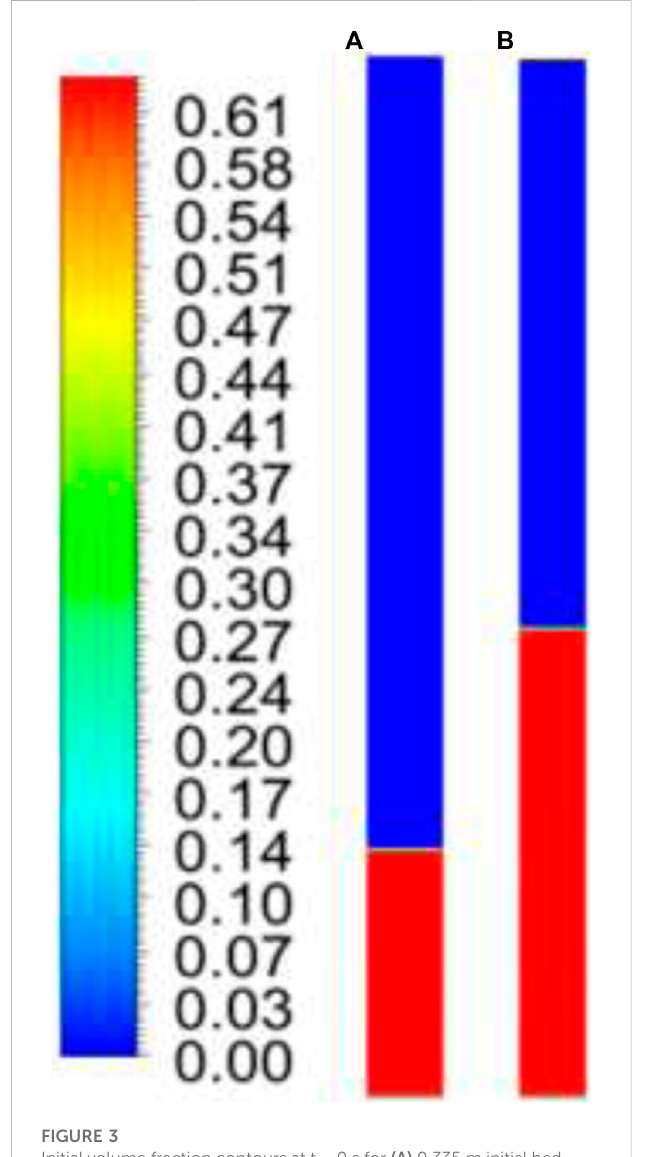
FIGURE 3 Initial volume fraction contours at t = 0 s for (A) 0.335 m initial bed height and (B) 0.635 m initial bed height.